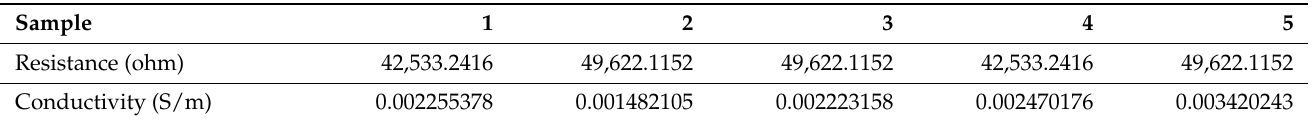
Table A8. Conductivity Data for Nylon 610 Nanocomposites with 2.5 wt% Graphite Nanosheets Treated at 175 ◦ C and − 1 bar.